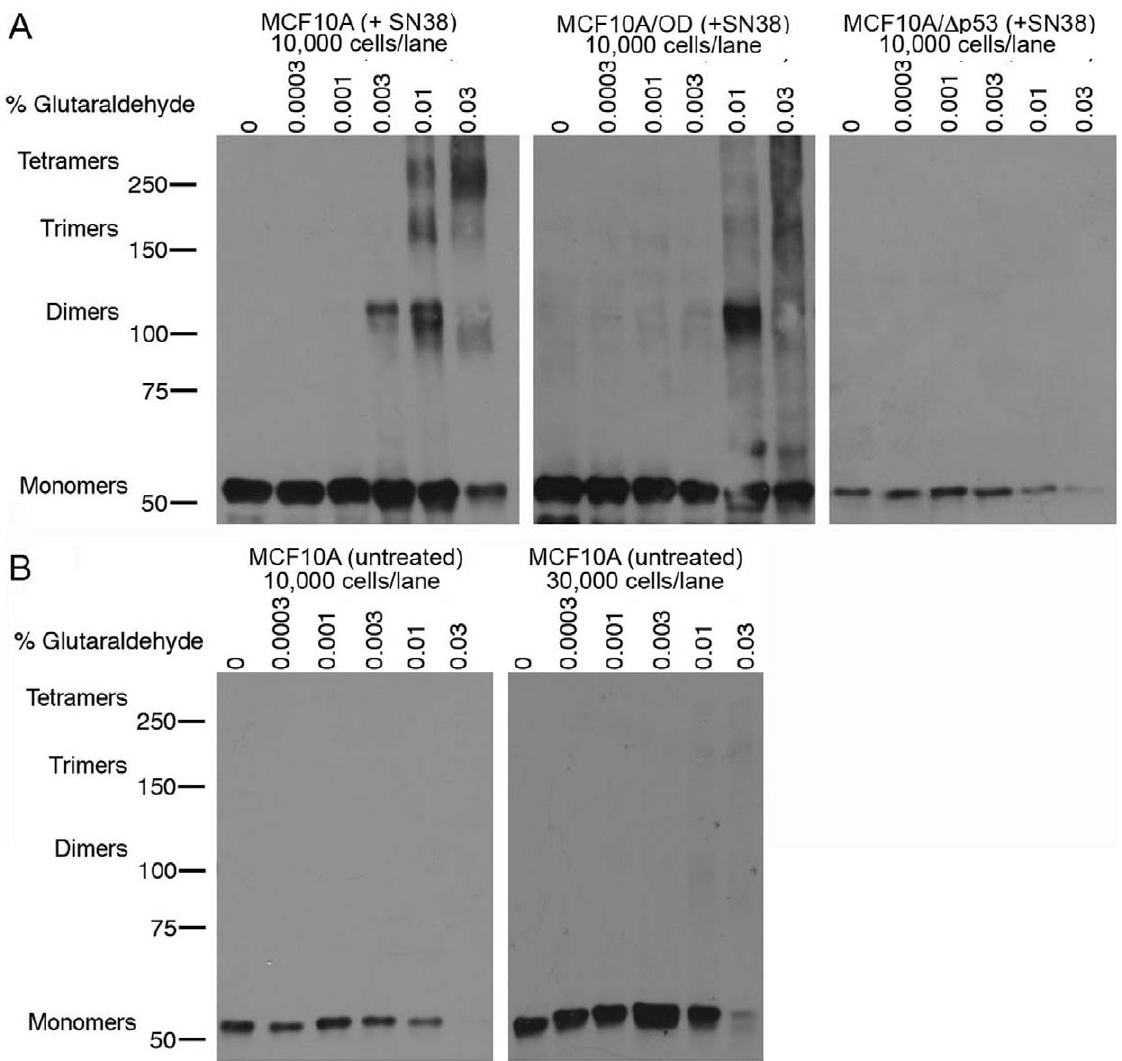
Figure 4. Determination of p53 oligomerization status using glutaraldehyde cross-linking. A , MCF10A, MCF10A/OD, and MCF10A/ D p53 and cells were incubated with 10 ng/ml SN38 ( + SN38) for 24 hours or B , fresh media (untreated) for 24 hours. Cells were harvested in lysis buffer and incubated with the indicated concentrations of glutaraldehyde for 5 minutes. The cross-linked lysates were then analyzed by SDS-Page followed by immunoblotting with p53-specific antibodies. Cell lysates were loaded at 10,000 or 30,000 cells/lane as indicated.